Question: Identify the chart type used in this figure.
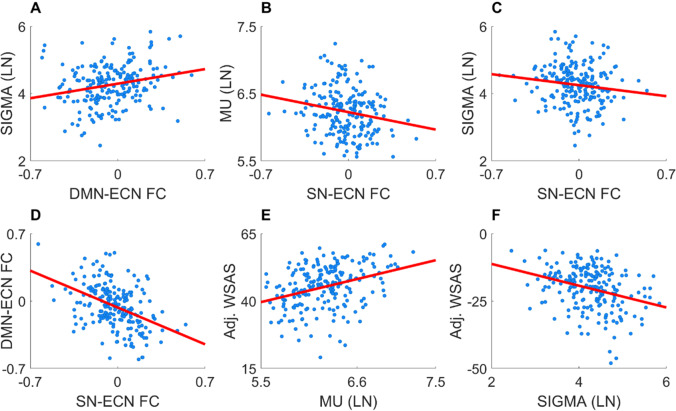
Answer: line